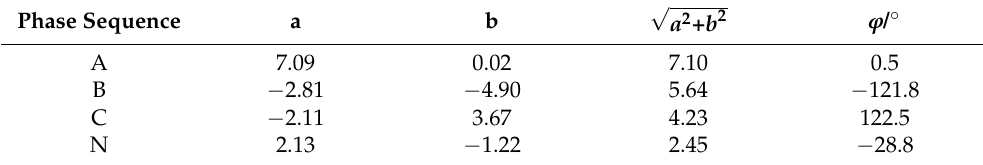
Table 2. Three-phase current reconstructed under simulation